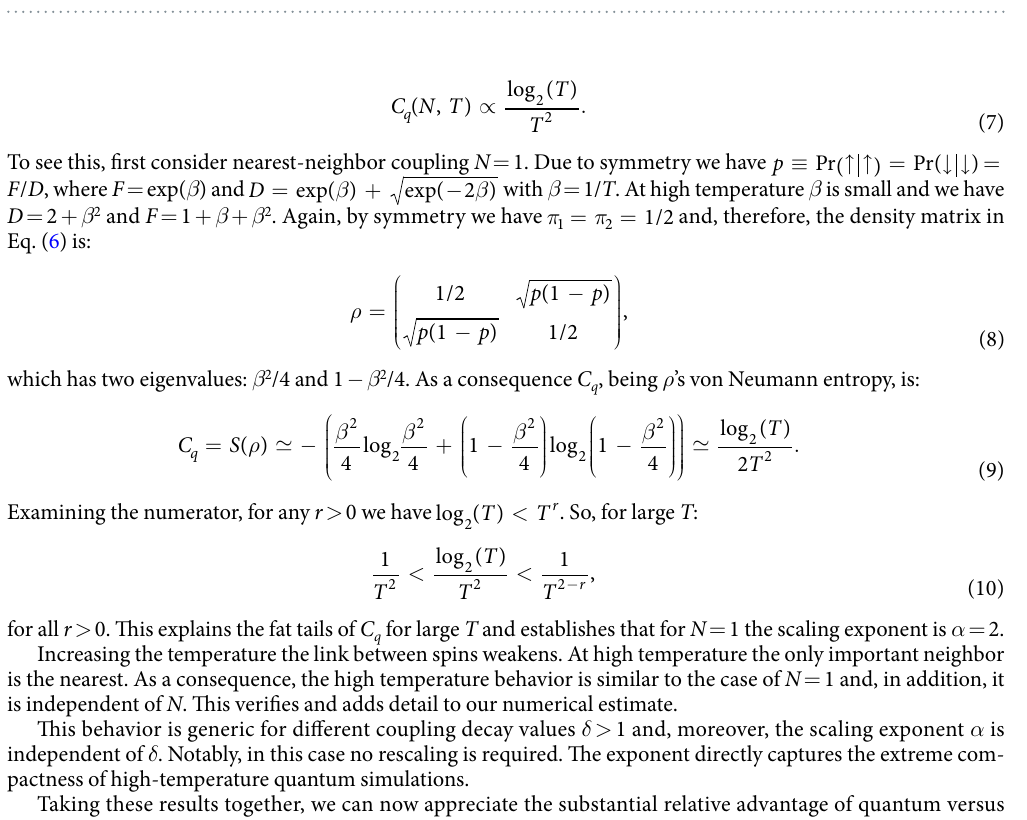
Figure 4. ( a ) C q (·) is an increasing function of N , but a decreasing function of T and bounded by 1 qubit, independent of N and T . Quantum memory C q ( N , T ), similar to C μ ( N , T ), shows a data collapse in N that is especially tight at high temperature ( T > 2). The asymptotic behavior is a power law with numerically estimated scaling exponent α = 2. (Red dashed line.) The lower inset zooms to highlight convergence with increasing N . Though the curves are for the case with δ = 2, the slope α at high T is independent of T . ( b ) Magnetic field effects on classical C μ ( N , T ) and quantum C q ( N , T ) memory requirements for simulating the processes  for N = 1, … , 6 over a range of temperatures T = 1, … , 10 at B = 0.3. C q ( N , T ) generated by Hamiltonian  N curves are those under the dashed blue